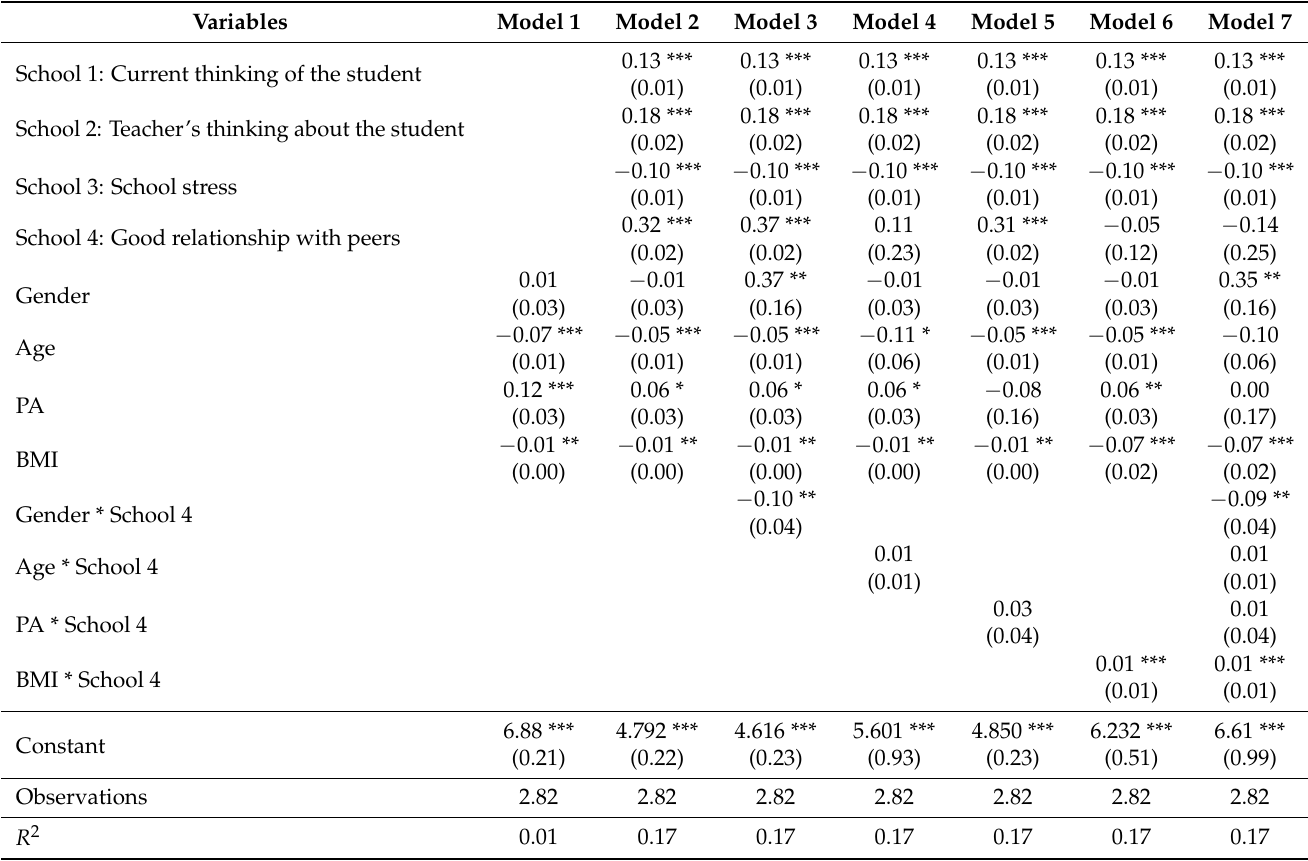
Table 3. Results table (hierarchical minimum quadratic linear regressions: coefficients, standard errors, and levels of